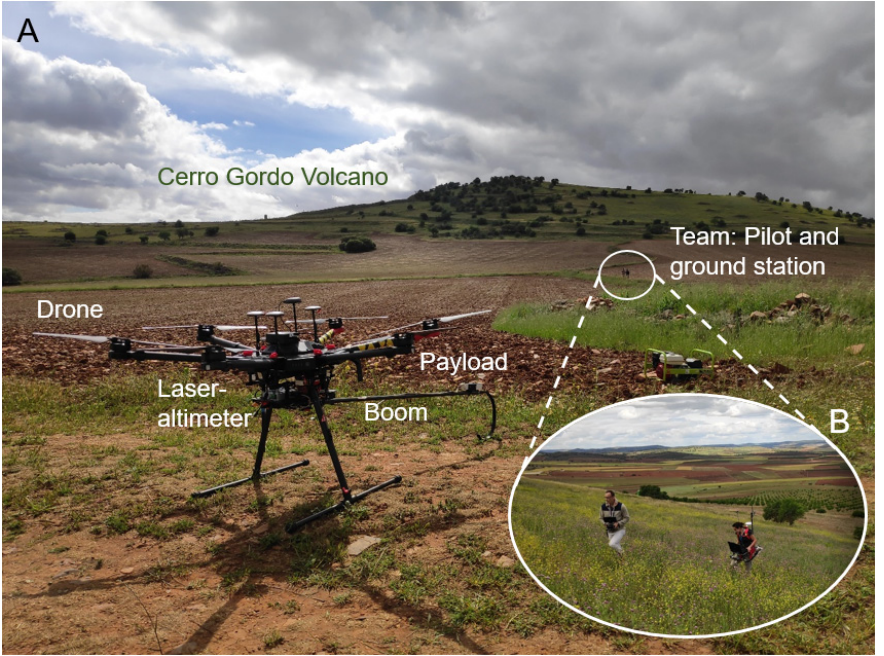
Figure 4. ( A ) Hexacopter-type drone provided with a laser altimeter in the landing configuration with the boom horizontal. ( B ) Mobile ground station for tracks longer than 500 m.